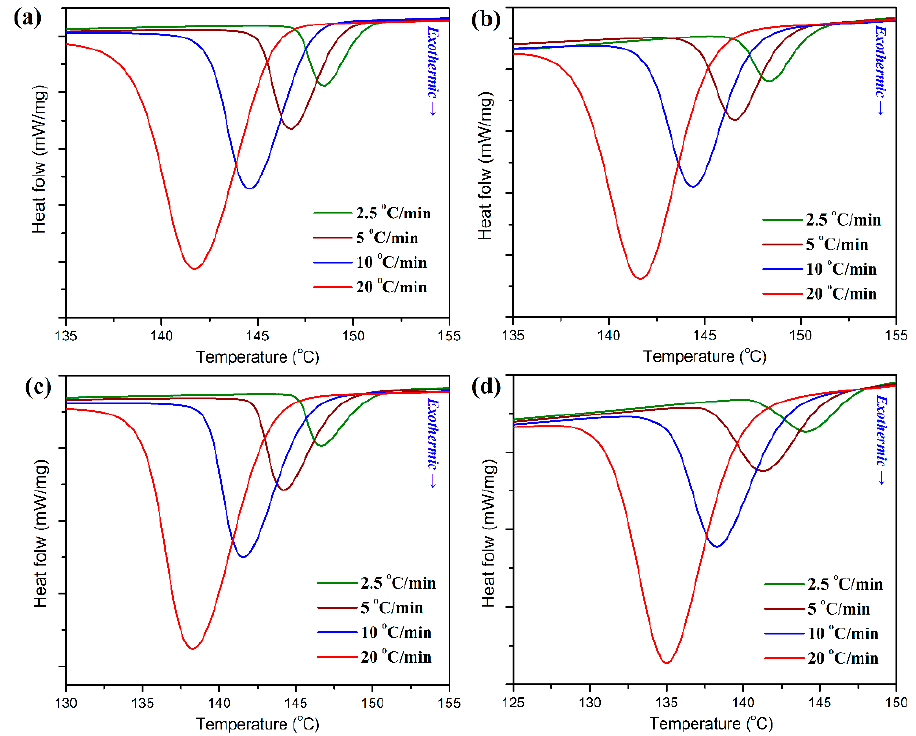
Figure 7. Differential scanning calorimetry (DSC) thermograms for the non-isothermal crystallization of ( a ) pure POM and its blends with ( b ) 10 wt %, ( c ) 20 wt %, and ( d ) 40 wt % of PLA at different cooling rates.